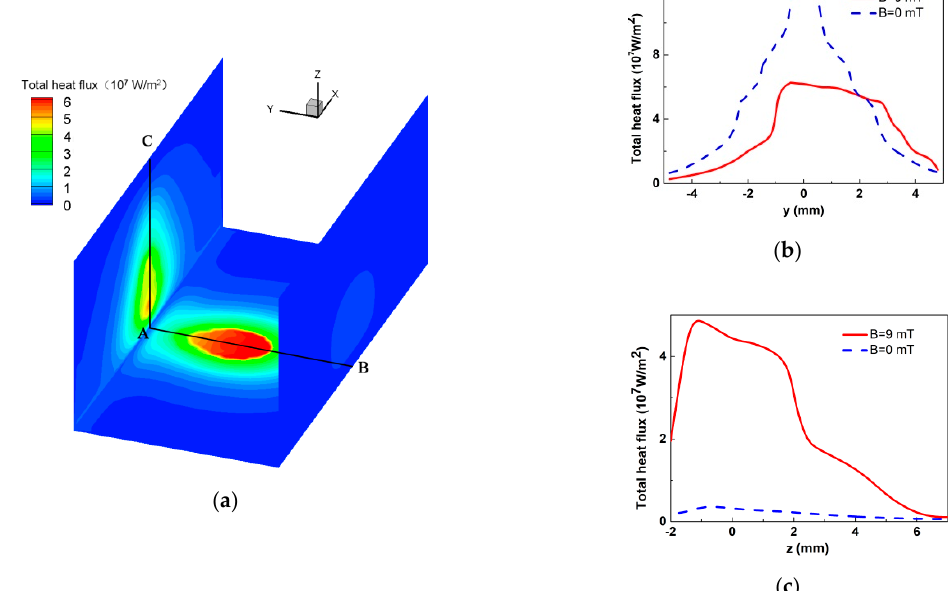
Figure 7. Total heat flux distribution: ( a ) Distribution of heat flux at groove faces; ( b ) Heat flux distribution along centerline AB; ( c ) Heat flux distribution along centerline AC (t = 0.027 s).